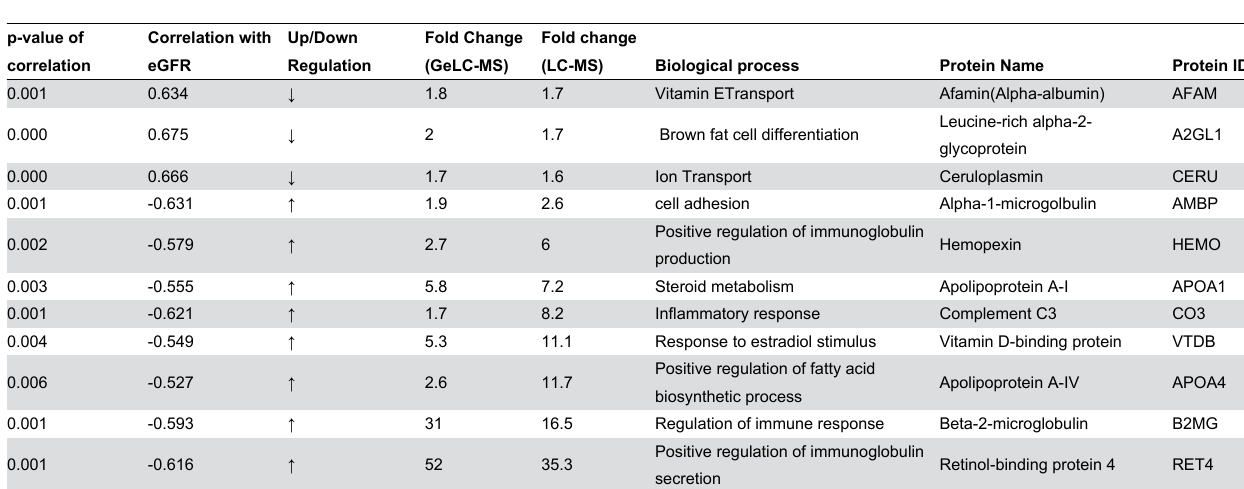
Table 3. Comparison of the proteomics-determined regulation of proteins and the values of eGFR (Estimated Glomerular Filtration Rate, an estimate of renal